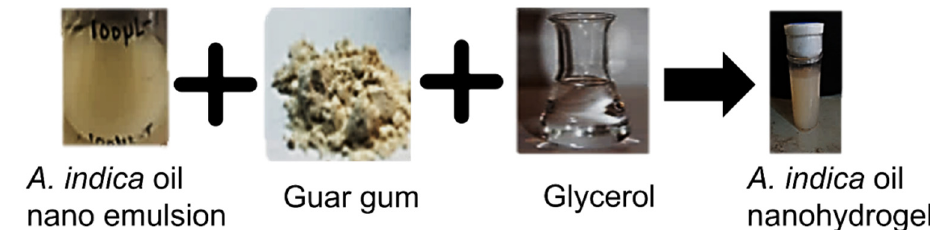
Figure 3. Different stages of nanohydrogel formulation of Azadirachta indica oil.